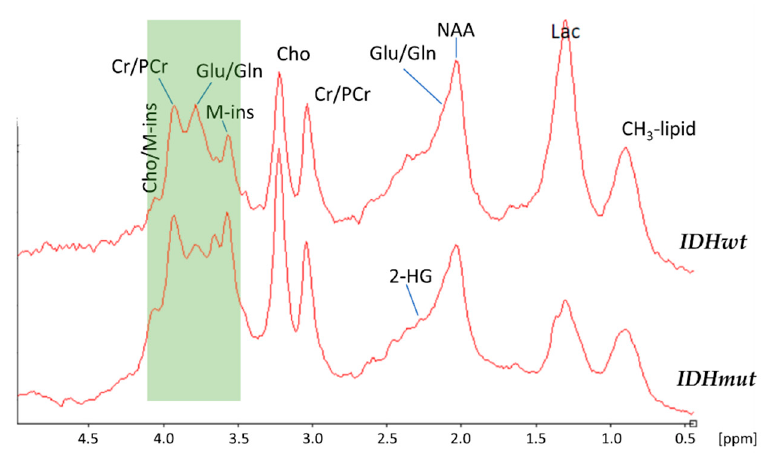
Figure 2. Averaged 1 H-MR spectra of IDHwt (n = 9, top) and IDHmut tumors (n = 17, bottom). The region between 4.1 ppm and 3.5 ppm (colored green) demonstrated distinct spectral differences between IDHwt and IDHmut 1 H-MR spectra.